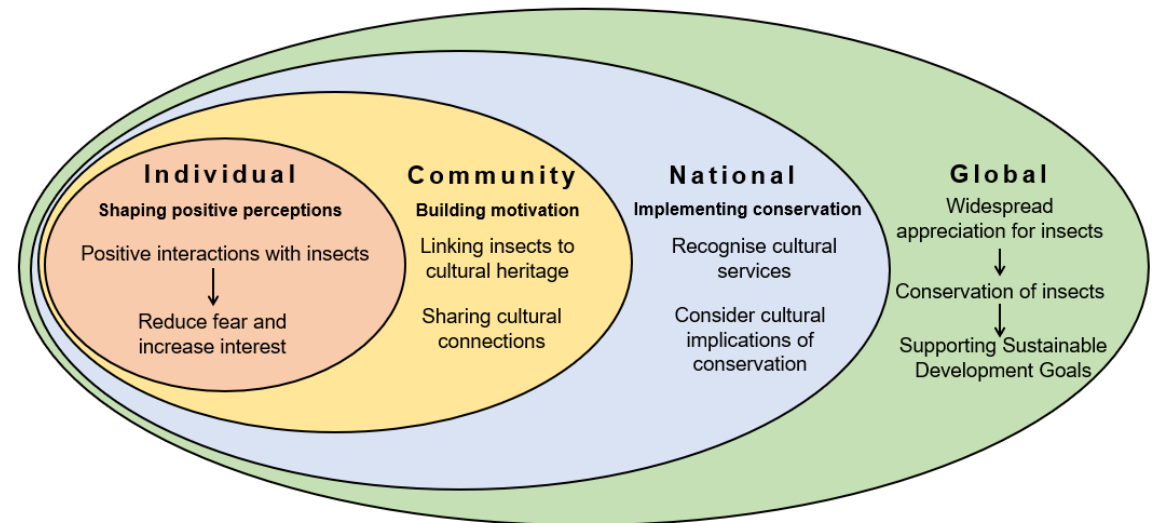
Figure 2. Multi-Level Framework: On the individual level, positive perceptions of insects can be fostered by positive experiences with insects. On the community level, experiences of cultural services can influence motives to conserve nature. On the national level, conservation for insects should be designed with the motivations of stakeholders and cultural services in mind. Globally, this framework will allow for effective conservation of insects.